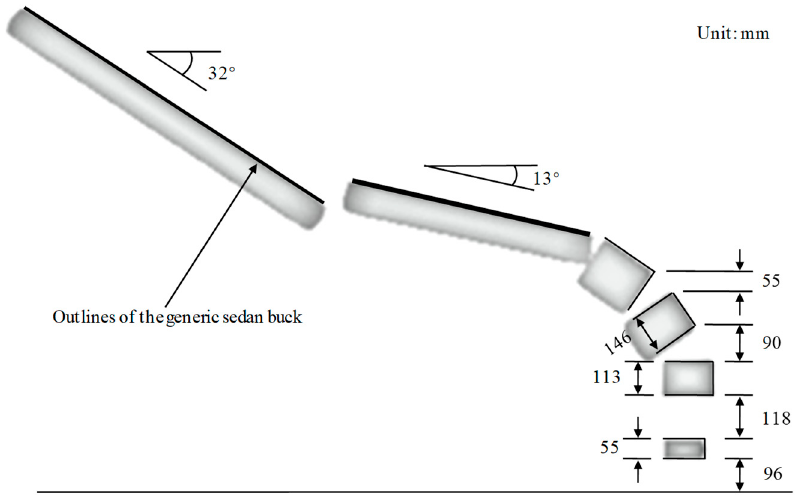
Figure A1. Schematic diagram of the structure of the generic sedan buck, modified from [50].